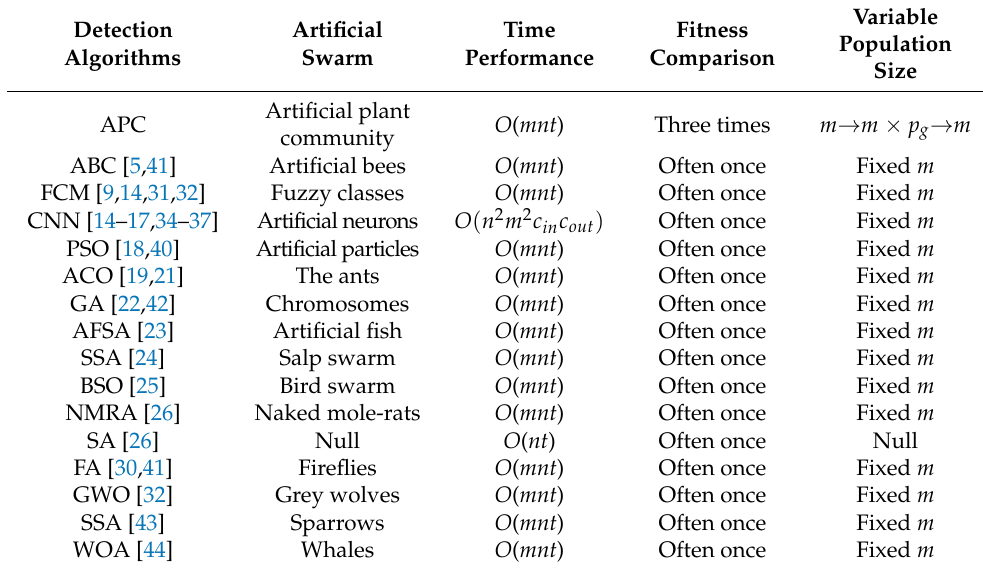
Table 6. Performance comparison summary of different artificial intelligence